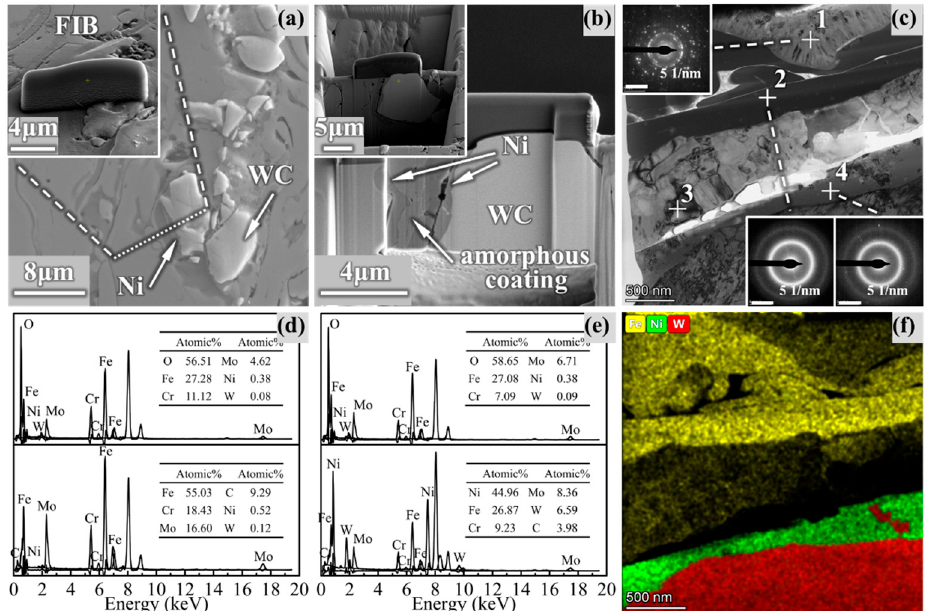
Figure 7. Microstructure analysis of the interface of amorphous/reinforcing phase particles: ( a , b ) the process of selecting target region and preparing TEM sample by FIB thinning technique; ( c ) mor- phology and SAED pattern of the Ni transition layer at the amorphous/WC interface; ( d ) EDS at point 1 and point 2; ( e ) EDS at point 3 and point 4; ( f ) map scanning of the main elements around the interface.